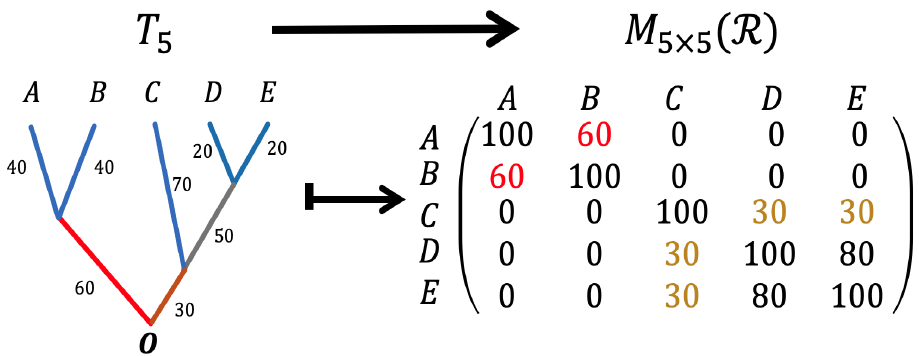
Figure 1. A rooted phylogenetic tree comprised of five taxa T 5 and its corresponding affinity matrix G 5 . Left panel: A rooted phylogenetic tree of five extant species A , B , C , D , E . Each branch of the tree has a length that represents the evolutionary time. Right panel: The affinity matrix G 5 , where the element g ij represents the amount of shared branch length from the root to the most common ancestor. The diagonal elements of G 5 have values of 100, as the distance from the root O to each tip A , B , C , D , E is 100. Each off-diagonal element g ij is the sum of the shared branch length between a pair of tips i and j . For instance, species A and species B have a shared branch length of 60 (red branch); hence, g AB = g BA = 60; while species C and species E share a branch of length 30 (brown branch), such that g CE = g EC =